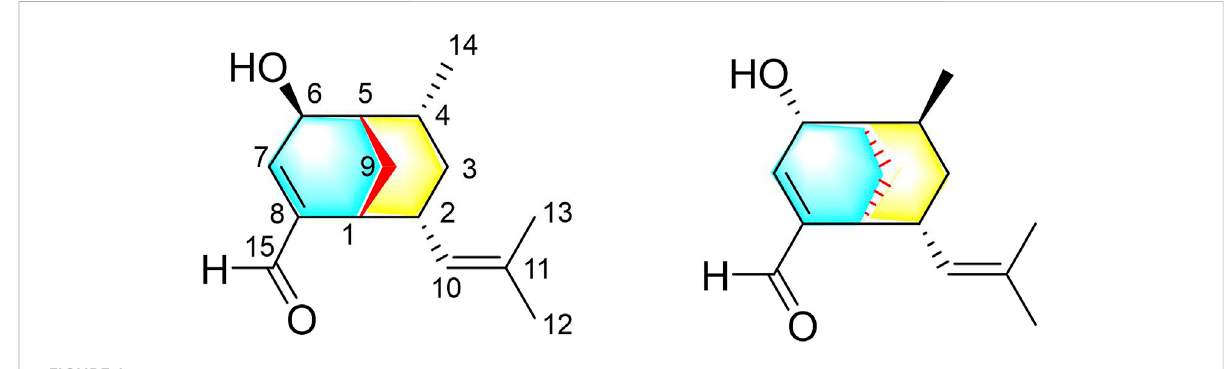
FIGURE 1 Structures of compounds 1 and 2